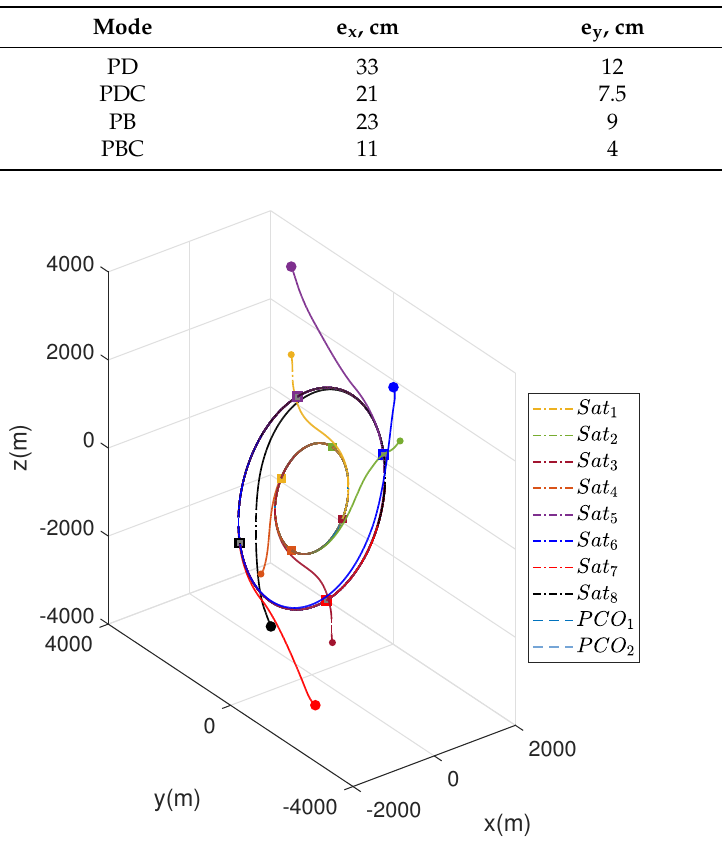
Figure 4. PD law: Plot of 3D